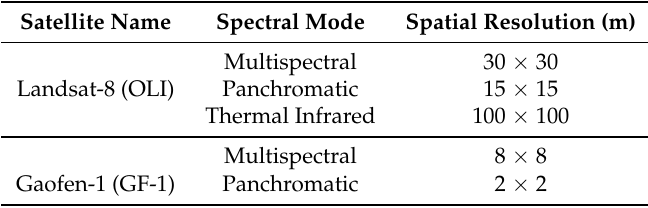
Table 1. Satellite data specifications.